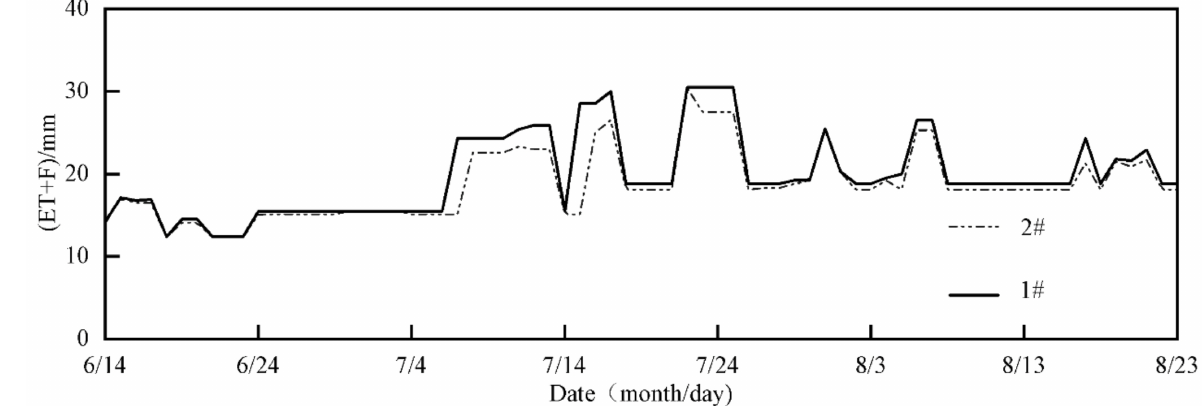
Figure 3. Comparison of the ET+F between points 1# and 2# in paddy